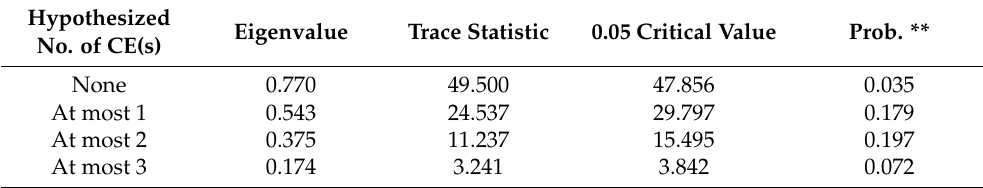
Table 4. Unrestricted Cointegration Rank Test (Trace).